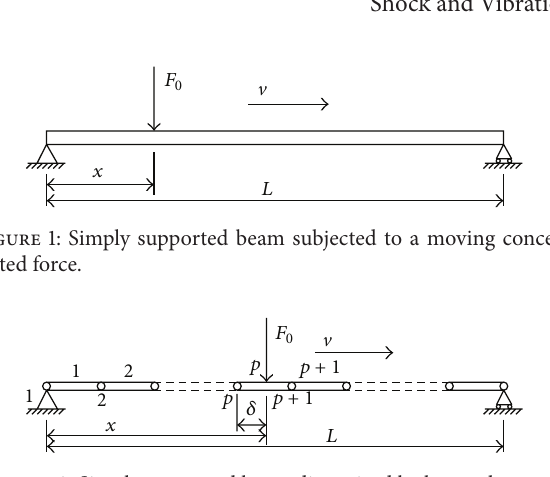
Figure 2: Simply supported beam discretized by beam